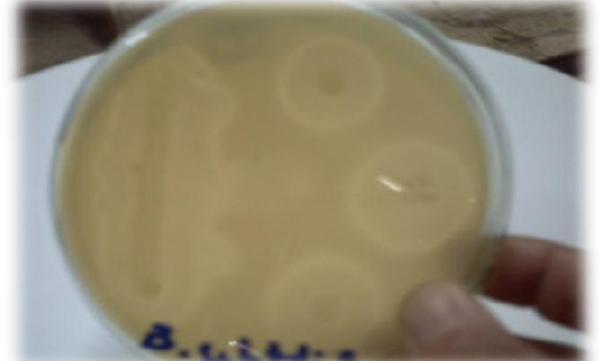
Fig(1) Inhibition zone of Bacillus subtilis against Aeromonas hydrophila after incubated Bacillus 1 day